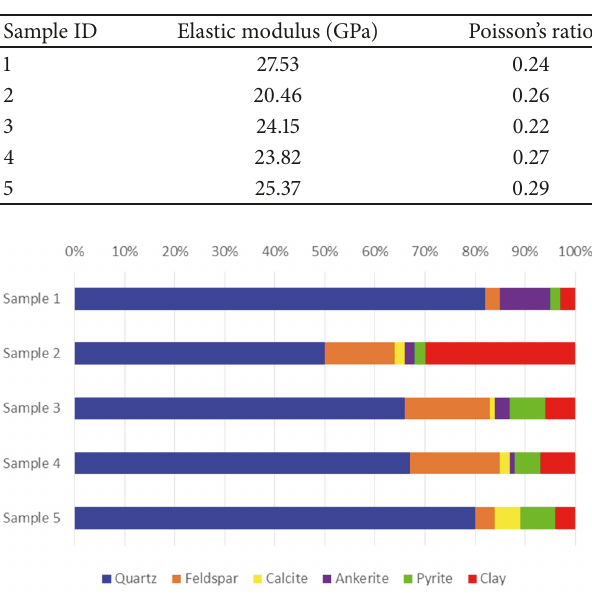
Figure 3: Mineral composition of the Lower Cambrian Niutitang Formation